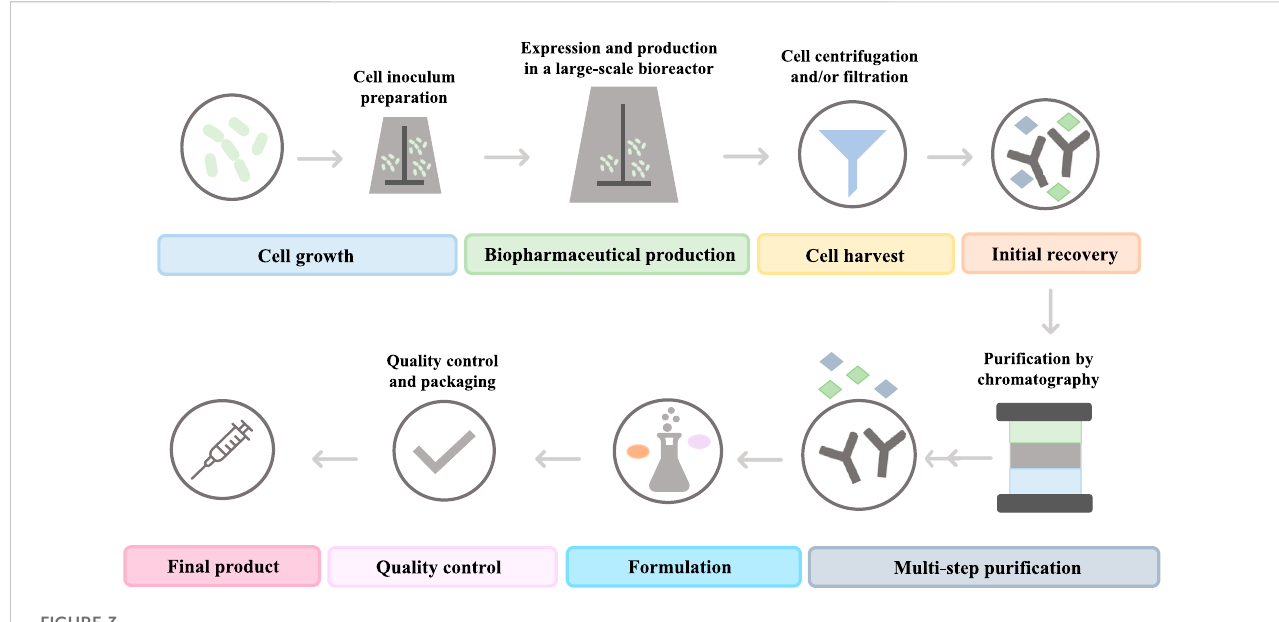
FIGURE 3 Representative overview of the general biomanufacturing of